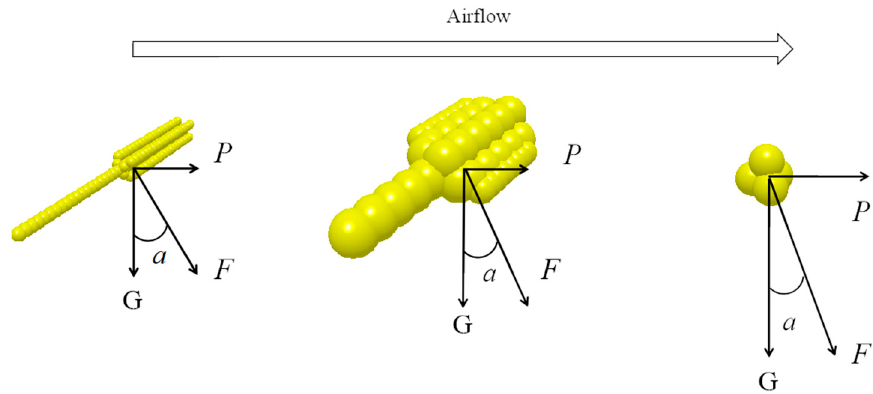
Figure 6. Force diagram of material particles.